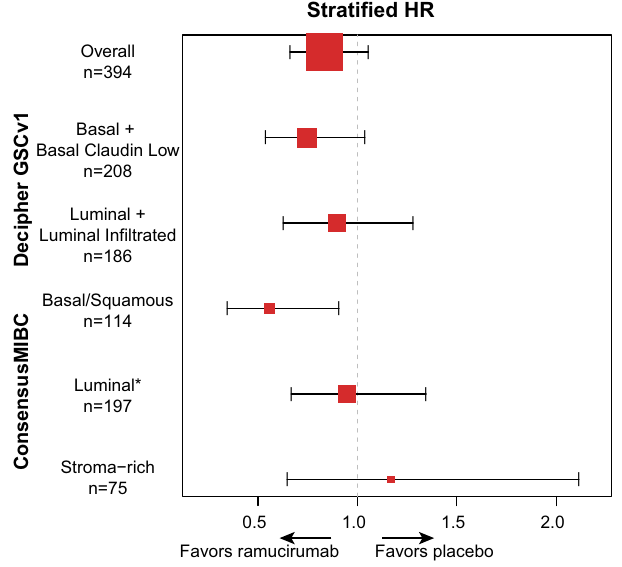
Fig. 5 Forest plot of strati fi ed HRs (95% CIs) for overall survival based on inferred cell type from both molecular subtype classi fi cations. The ConsensusMIBC Neuroendocrine subtype had too few observations ( n = 8 participants) for a stand-alone analysis and was not included. Data are presented as estimated HR with error bars indicating the 95% CI and box size indicating the sample size. The TR2 population ( n = 394 participants) is used. Number of participants for each subgroup are: Basal + Basal Claudin Low, n = 208 participants; Luminal + Luminal In fi ltrated, n = 186 participants; Basal/Squamous, n = 114 participants; Luminal*, n = 197 participants; and Stroma-rich, n = 75 participants. * “ Luminal ” grouping within the ConsensusMIBC classi fi cation includes Luminal Papillary, Luminal Unstable, and Luminal Non-Speci fi ed. Source data are provided as a Source Data fi le. CI, con fi dence interval; HR, hazard ratio; n, number of